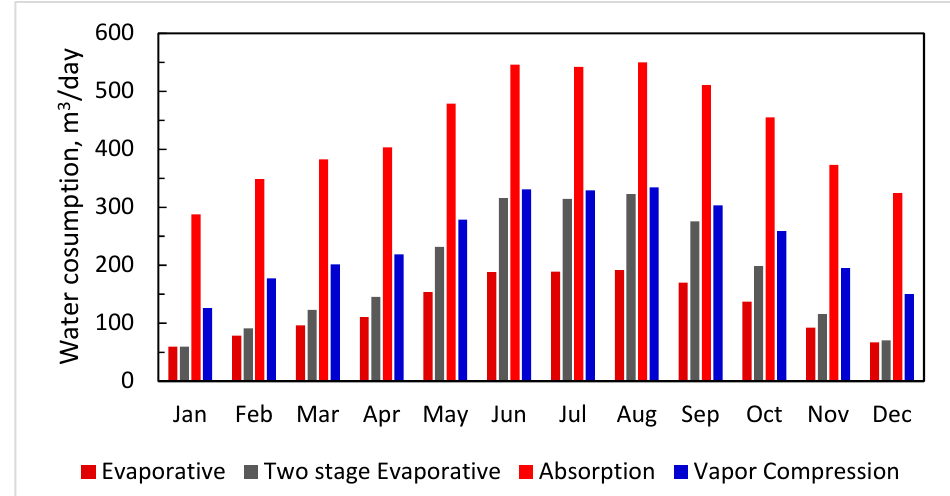
Figure 17. Water consumption of different inlet cooling systems.